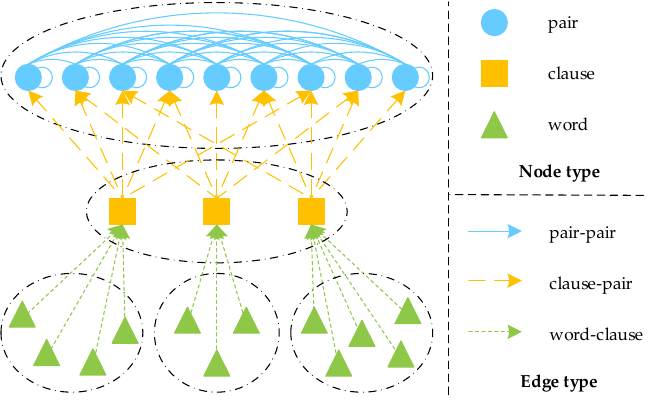
Figure 1. A toy example of heterogeneous graph composed of word, clause, and pair nodes.